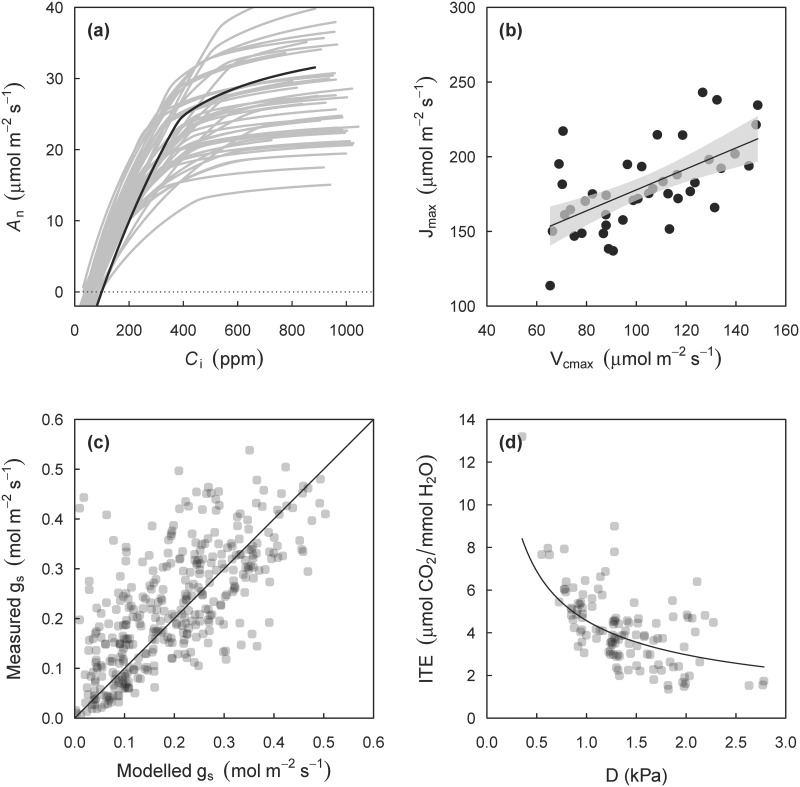
Example application of the plantecophys package to A-Ci curves and spot gas exchange measurements on Eucalyptus delegatensis.(A) Fitted A-Ci curves with one curve highlighted (B) Estimates of Jmax plotted against Vcmax, obtained from the fitted curves in panel (A). Solid line is a regression line (Jmax = 107.71 + 0.7 Vcmax, R2 = 0.36) with a 95% confidence interval for the mean. (C) Modelled (with the model of Medlyn et al. 2011) versus measured gs (p < 0.0001, R2 = 0.69). Measurements included a wide range of environmental conditions (PAR, Tleaf, D). In this example, only g1 was fit (estimate = 3.31, 95% CI = 3.15–3.47). (D) The predicted response of ITE (An / E) as a function of D from the fitted model in panel (C) (solid line), and the measurements from panel (C) when PAR > 1000.